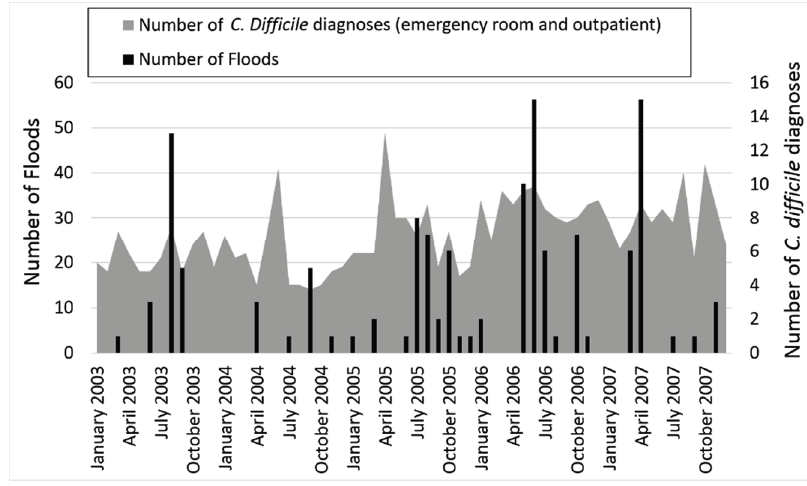
Figure 2. Flooding and Clostridium difficile diagnoses over time.